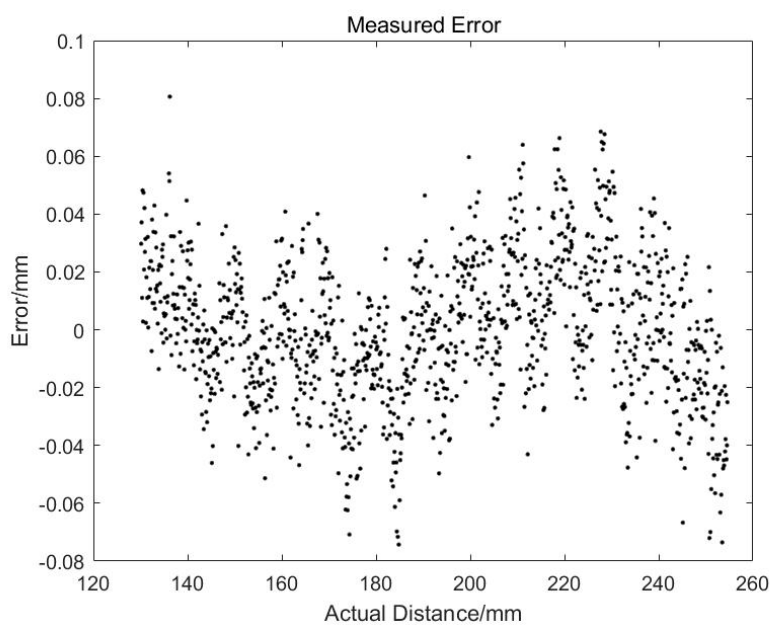
Figure 12. System error after compensating.